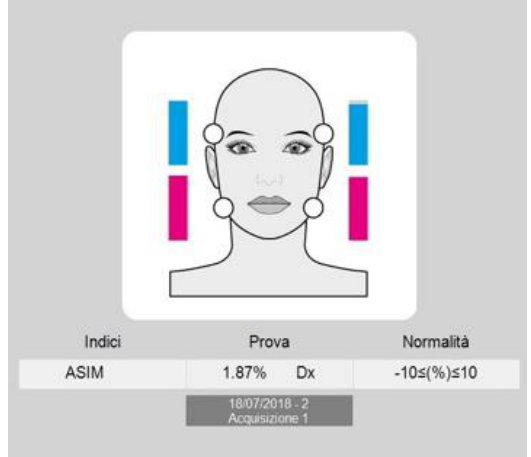
Figure 2. Electromyographic evaluation of muscles asymmetry expressed with the relative ASIM index and through a visual representation of the progressive recruitment of Temporalis muscles in blue and Masseter muscles in